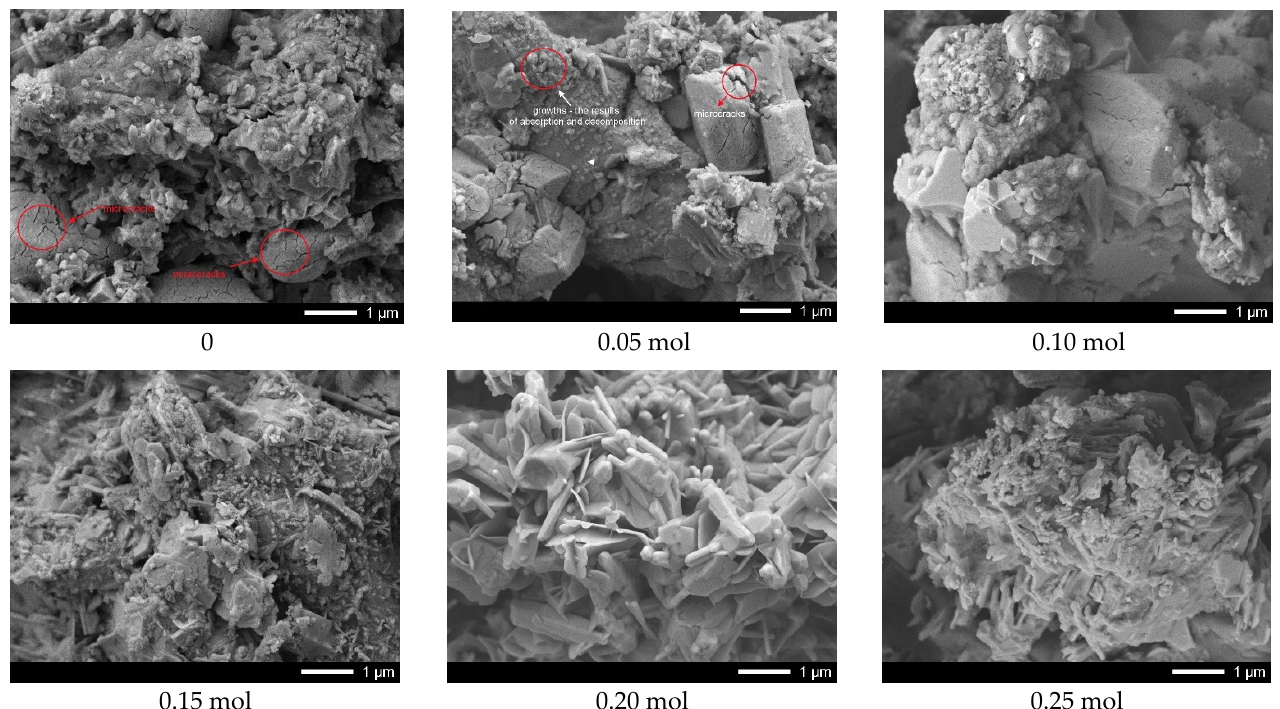
Figure 9. Results of ceramic surface morphology after 5 test cycles.